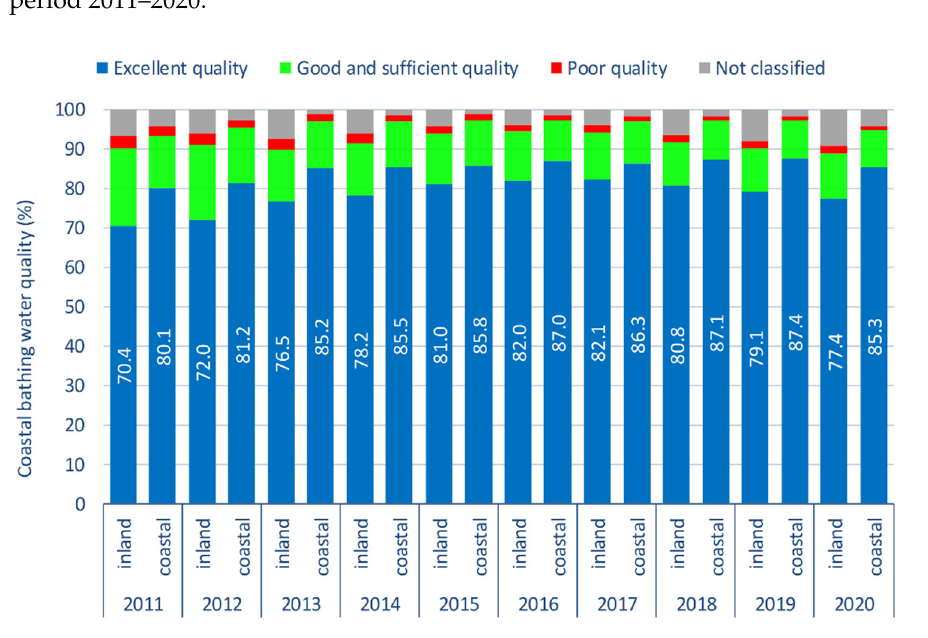
Figure 13. Inland and coastal bathing water quality in the EU between 2011 and